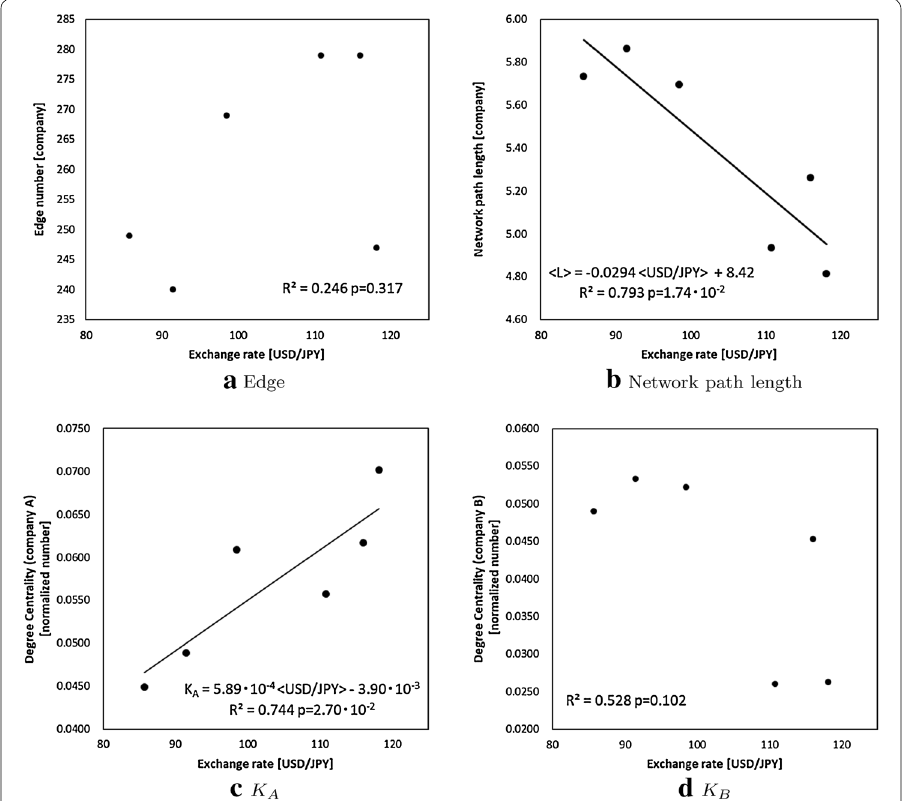
Fig. 6 Two network indexes with the USD/JPY exchange rate: a The edge number as the macroscopic index shows no correlation. b The network path length as a microscopic index shows a negative correlation. c The degree centrality of company A as a microscopic index shows a positive correlations. d The degree centrality of company B as a microscopic index shows no